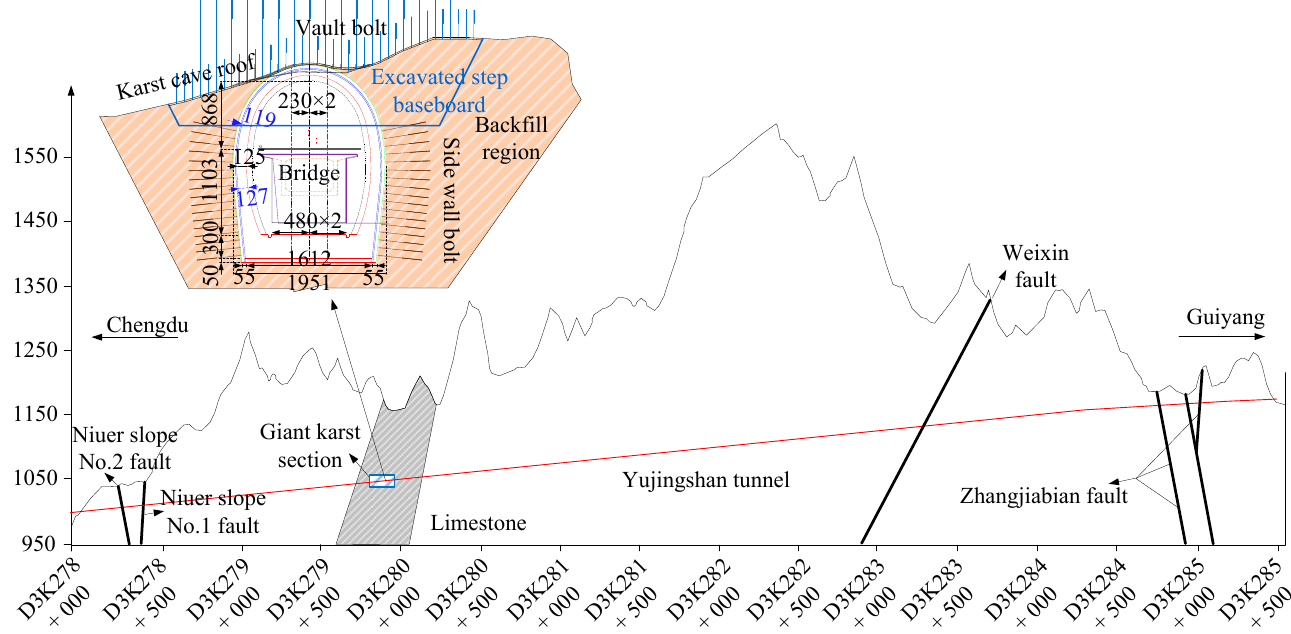
Figure 1. Design profile of tunnel infrastructure.